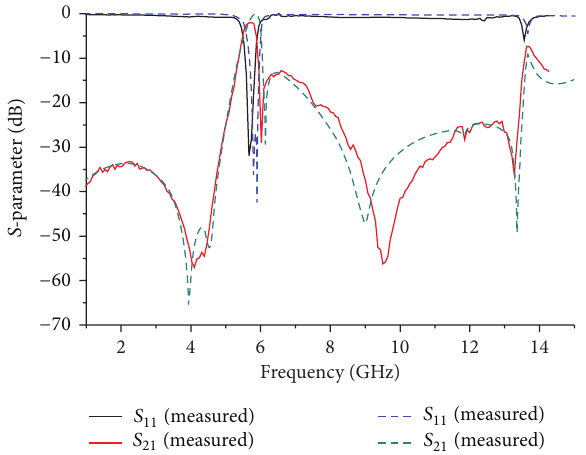
Figure 7: Simulation and measurement results of the proposed BPF with the proposed